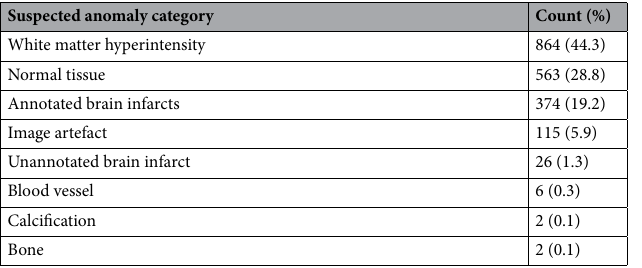
Table 2. Suspected anomaly categories in the 225 test subjects (Total: 1953. On average: 9 suspected anomalies per image). The suspected anomalies were categorized in eight categories, where the categorization was performed manually by a trained radiologist, except for the ‘annotated brain infarcts’ (these annotations were already available from the used image